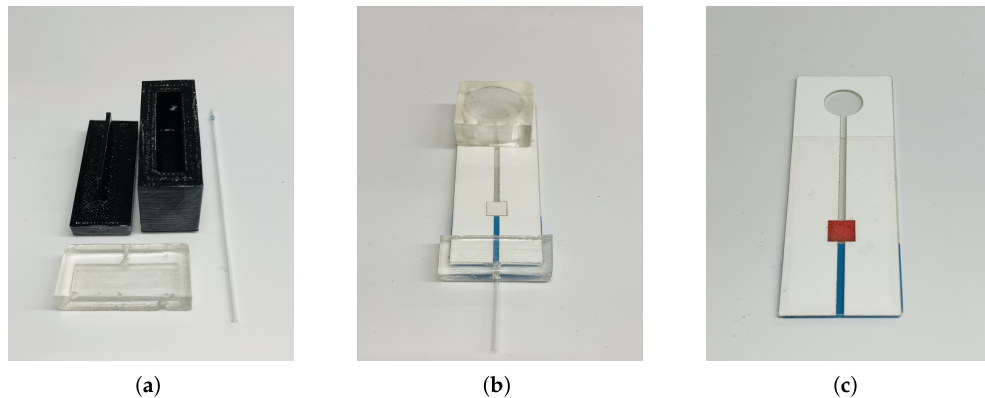
Figure 4. ( a ) 3D-printed mold for the extension part and PDMS extension with dipping glass capillary; ( b ) Whole device after assembling; ( c ) Filter paper with the blood completely